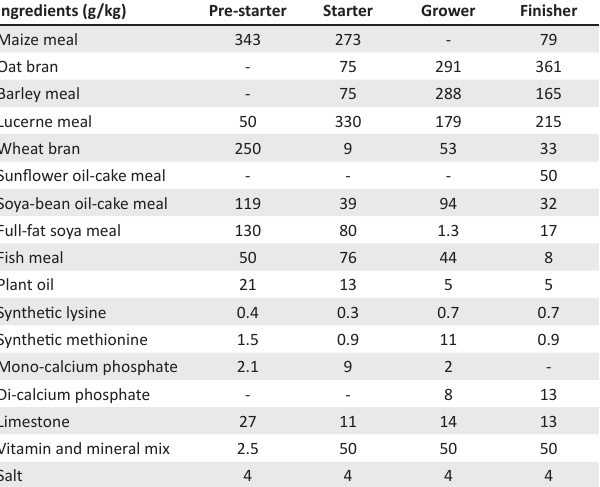
TABLE 2: Representation of the raw material inclusions for the medium energy and medium protein inclusions for each growth phase. These are the standard requirements for energy and